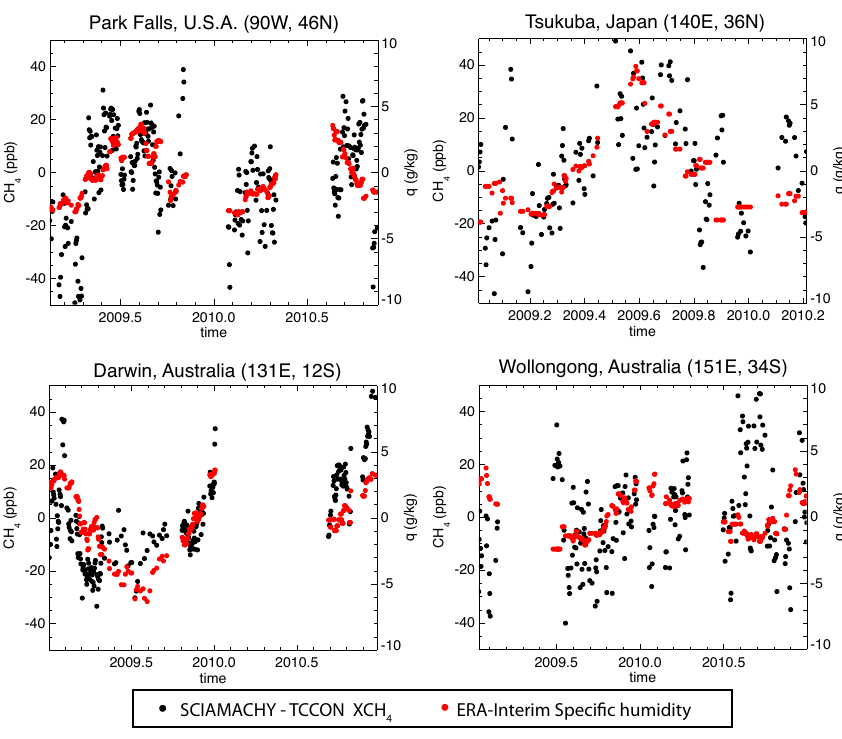
Fig. 2. Seasonal variation of residuals between colocated SCIAMACHY and TCCON measurements (black, left y-axis) and its relation with ERA-interim derived speci fi c humidity averaged between the surface and 3 km altitude (red, right y-axis).